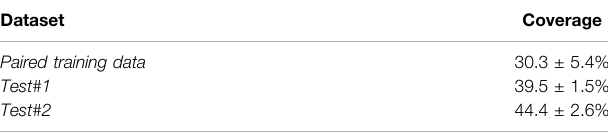
TABLE 5 | The point cloud coverage over the left atrium for the generated ( Paired training ), clinical MRI ( Test #1 ), and clinical CT ( Test #2 ) datasets.